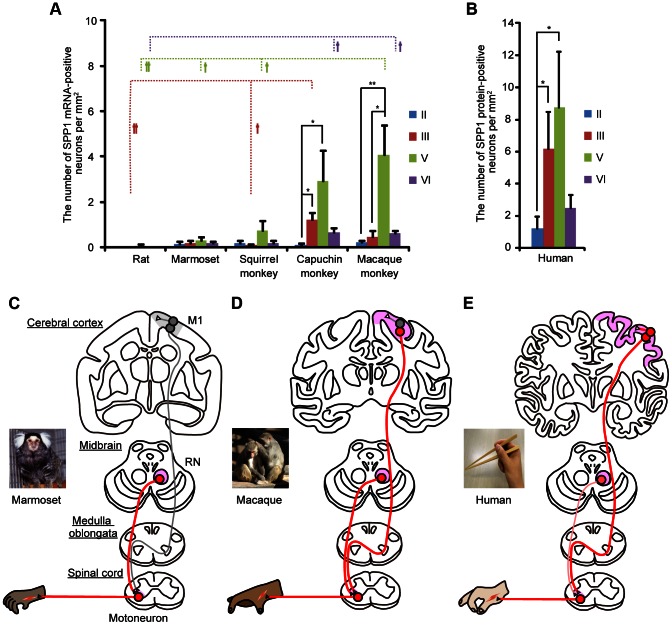
Summary of the results from the species differences analysis.A: The density of SPP1 mRNA-positive neurons in each layer of the primary motor cortex (M1) in five animals: rat, marmoset, squirrel monkey, capuchin monkey, and rhesus macaque (the number of sections in each species was 6, 6, 10, 4, and 6, respectively). The mean density of SPP1 mRNA-positive neurons (± SE) is shown. *P<0.05, **P<0.01, according to a Friedman's one-way analysis of variance (ANOVA) with Dunn's post-hoc tests. †P<0.05, ††P<0.01, according to a Kruskal–Wallis one-way ANOVA with Dunn's post-hoc tests. B: The density of SPP1 protein-positive neurons in each layer of M1 in human (n = 6 sections). The mean density of SPP1 protein-positive neurons (± SE) is shown. *P<0.05, **P<0.01, according to a Friedman's one-way analysis of variance (ANOVA) with Dunn's post-hoc tests. C–E: Schematic diagram of the interspecies differences in SPP1 expression in the projection neurons of motor-related structures including M1, red nucleus (RN), and lower cervical spinal segments. The motor systems are organized in a functional hierarchy from bottom to top: the spinal cord, brainstem, and motor cortex, each associated with increasing levels of complexity. SPP1 was commonly expressed in motor-related areas among all species examined; however, the level of motor hierarchy in which this gene was expressed varied among species. The regions with intense or moderate SPP1 signals are shown as red-filled circles, and those with weak or no signals are shown as gray-filled circles. See Table 4 for expression data details from the RN and spinal cord of each species.